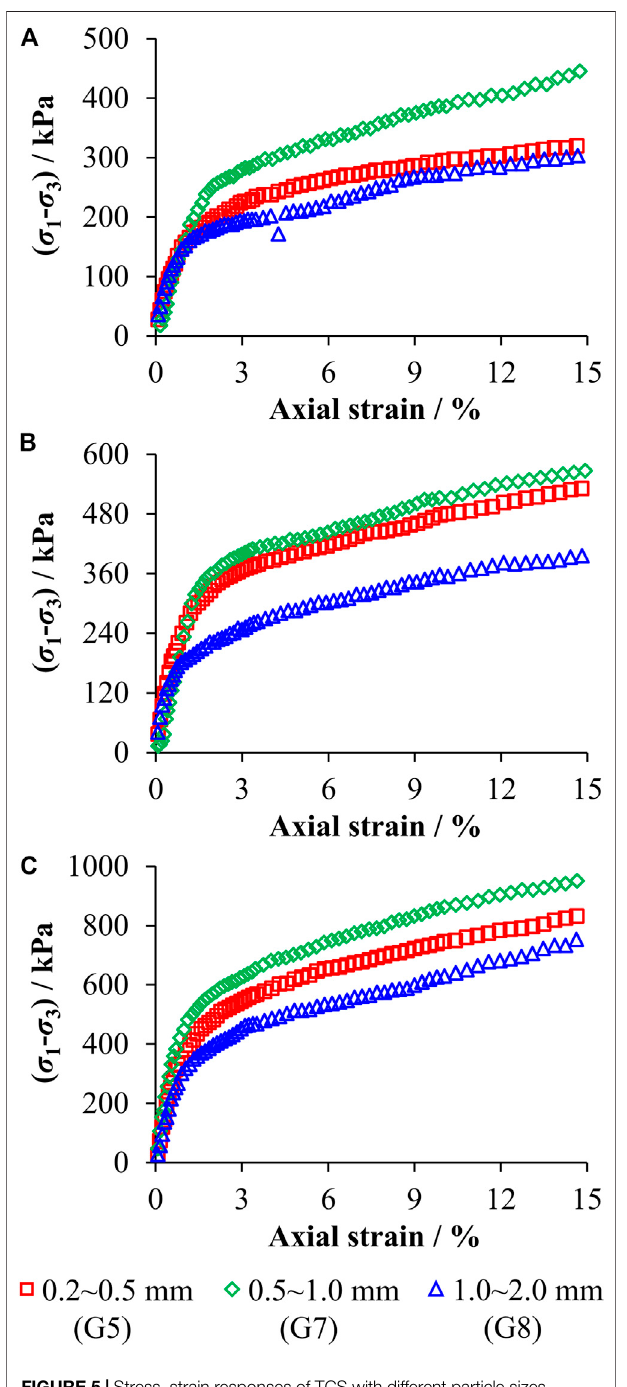
FIGURE 5 | Stress – strain responses of TCS with different particle sizes of fused quartz at con fi ning pressures of 50 (A) , 100 (B) , and 200 kPa (C) .